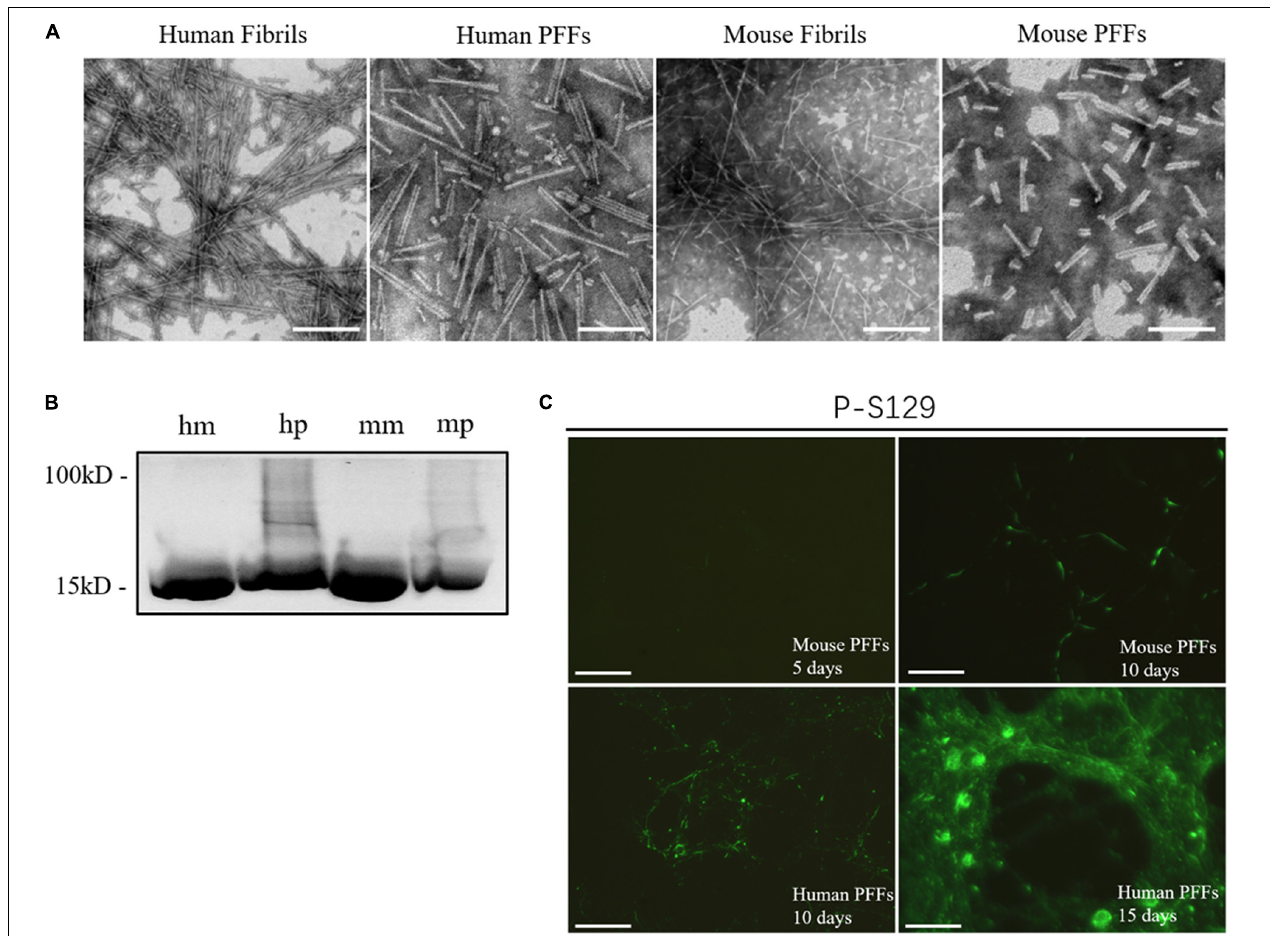
FIGURE 1 | Synthetical PFFs induced the LB/LN pathology in mouse primary neuronal cells. (A) Typical fibril morphology of human/mouse fibrils/PFFs under the negative-stain transmission electron microscopy. (B) Coomassie blue staining of α -synuclein monomer and fibril seeds. (C) Fluorescent staining of phosphorylated α -synuclein in mouse primary neuronal cells. Time-dependent increase of phosphorylated pathological α -synuclein can be observed in human and mouse fibril seeds-treated neurons (5 days, 10 days, and 15 days, respectively). LB/LN pathology spread from the neuron axon to the cell body. After 5 days treated with mouse α -synuclein PFFs (1 µ g/ml), almost no phosphorylation of pathological α -synuclein is produced, scale bar = 100 µ m; Treated with mouse α -synuclein PFFs (1 µ g/ml) for 10 days, a small amount of phosphorylation pathological α -synuclein can be observed, scale bar = 100 µ m; After 10 days treated by human α -synuclein PFFs (1 µ g/ml), a large number of phosphorylated pathological LN distributed along the axons of neurons and there was a tendency to accumulate in the cells, scale bar = 100 µ m; Treated with human α -synuclein PFFs (1 µ g/ml) for 15 days, a large number of round aggregates LB appeared in the neuronal soma, scale bar = 50 µ